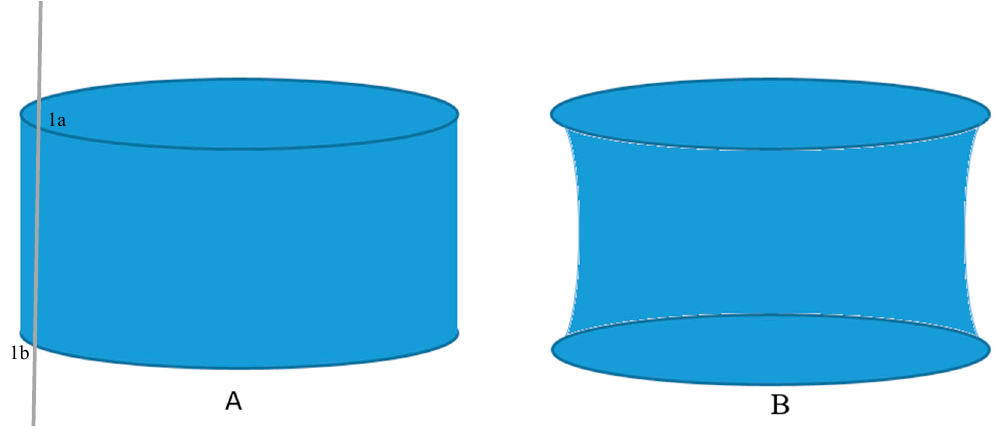
Figure 13. Encoding curved surfaces in LandXML.